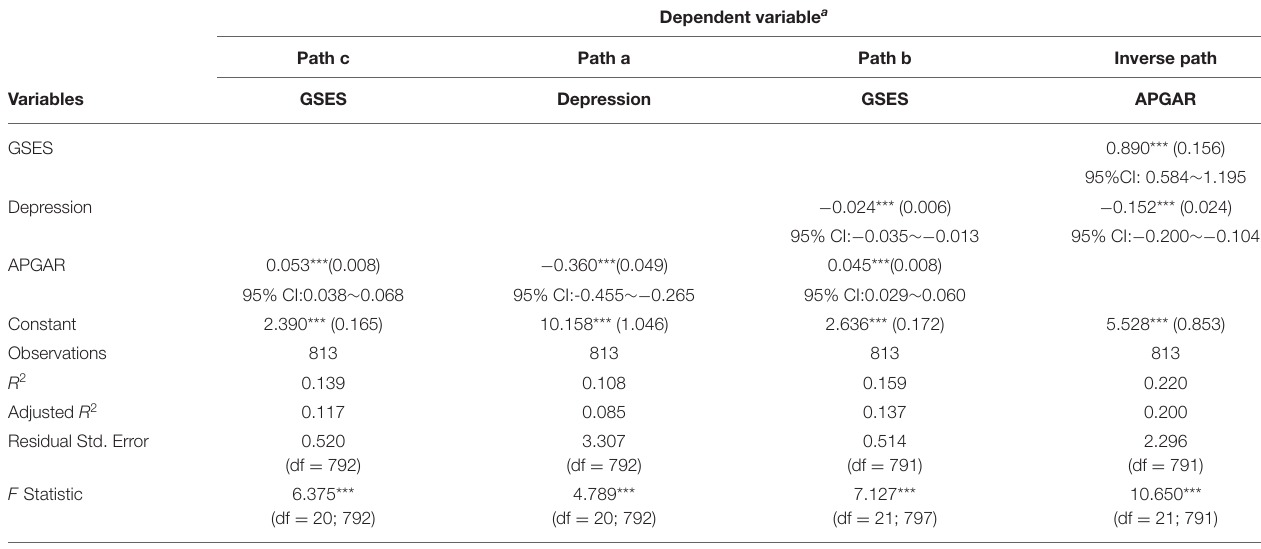
TABLE 3 | Mediation model showing role of depression symptom on relationship between family function and self-efficacy, β (SE), and 95%CI for β .